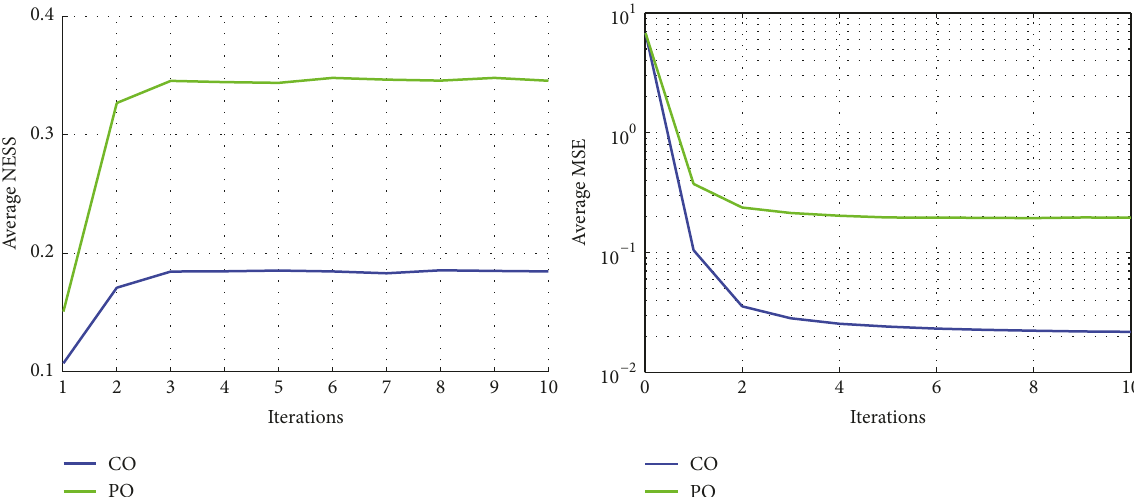
Figure 2: Evolution along the iterations of the NPMC algorithm of the average NESS ( left ) and MSE ( right ) in the CO and PO scenarios, estimating a single parameter 𝜃 1 .